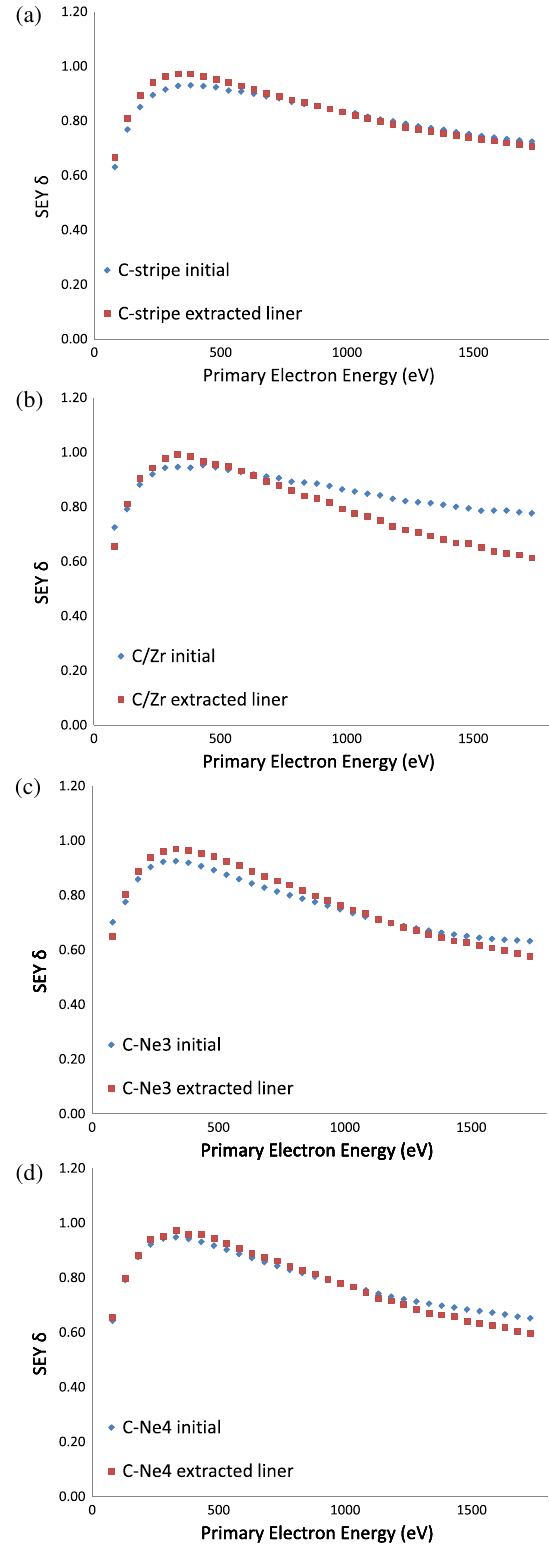
FIG. 14. SEY measurements on four a-C coated liners before and after operation in the SPS. (a) C-stripe, a-C coating used for confirming the minimum of coating width. (b) C = Zr , a-C on rough Zr coating. (c) C-Ne3. (d)